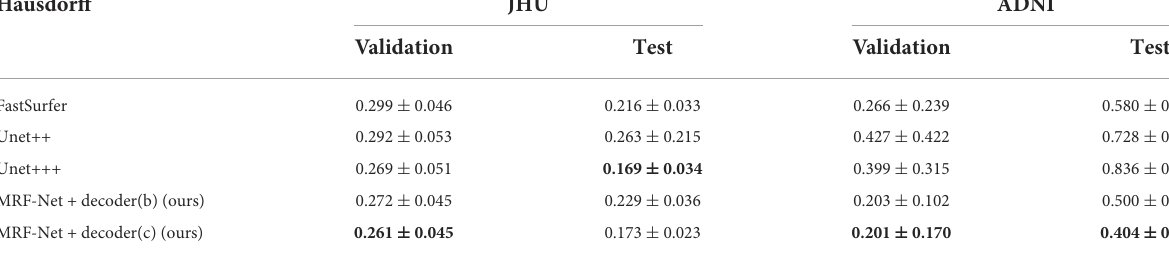
TABLE 2 The hausdorff distance scores for 4 comparative networks on the axial segmentation results.